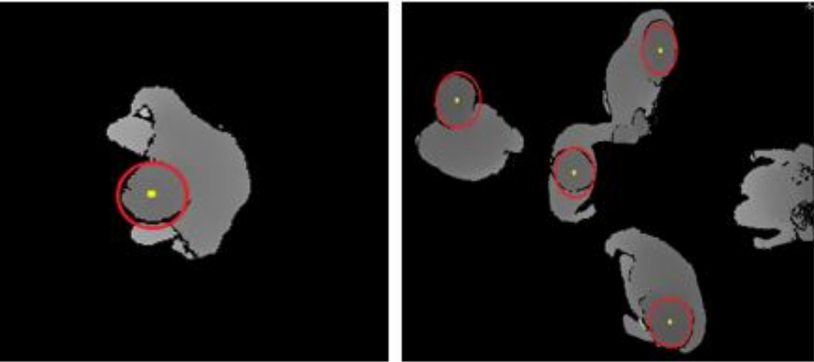
Figure 3. Final results of head detection using the HCGT technique over the GOTPD dataset.